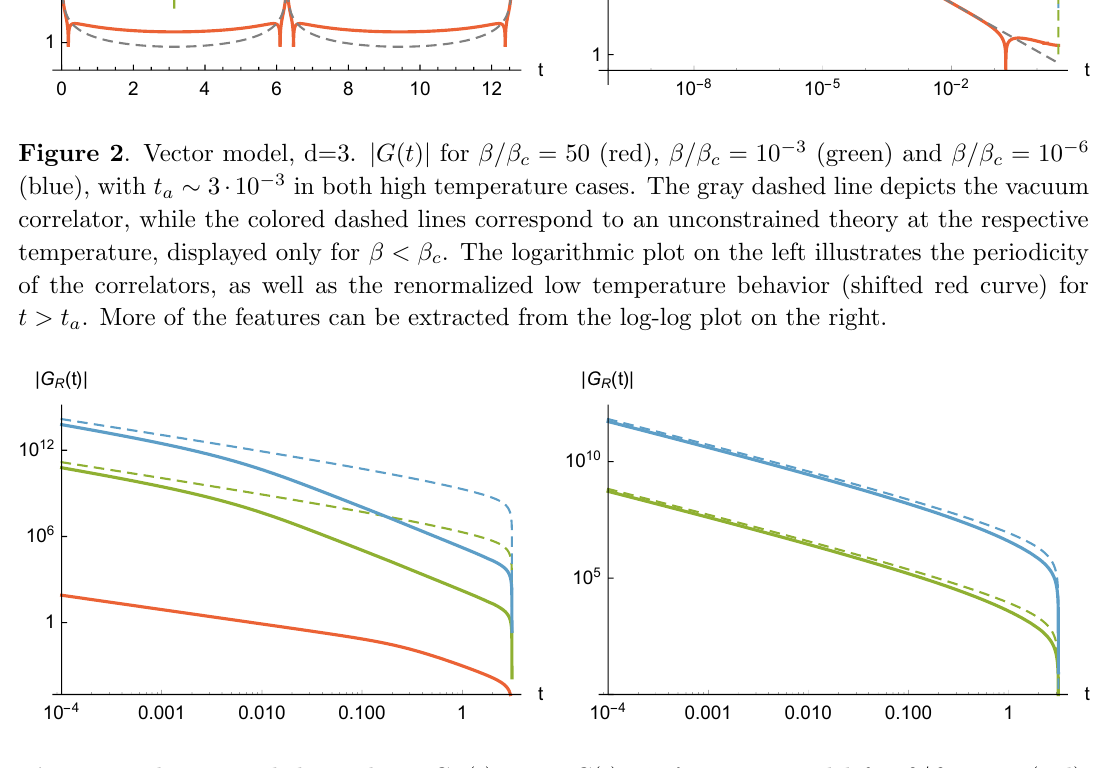
Figure 3 . d=3, retarded correlator G R ( t ) = Im G ( t ). Left: vector model for (cid:12)=(cid:12) c = 50 (red), (cid:12)=(cid:12) c = 10 (cid:0) 3 (green) and (cid:12)=(cid:12) c = 10 (cid:0) 6 (blue). The dashed lines depict the result of an unconstrained theory at the corresponding temperatures. The crossover times are as in (cid:12)gure 2. Right: adjoint model for same values of (cid:12)=(cid:12) c . The imaginary part vanishes below the transition. The crossover times are at t a (cid:24) 1 for both